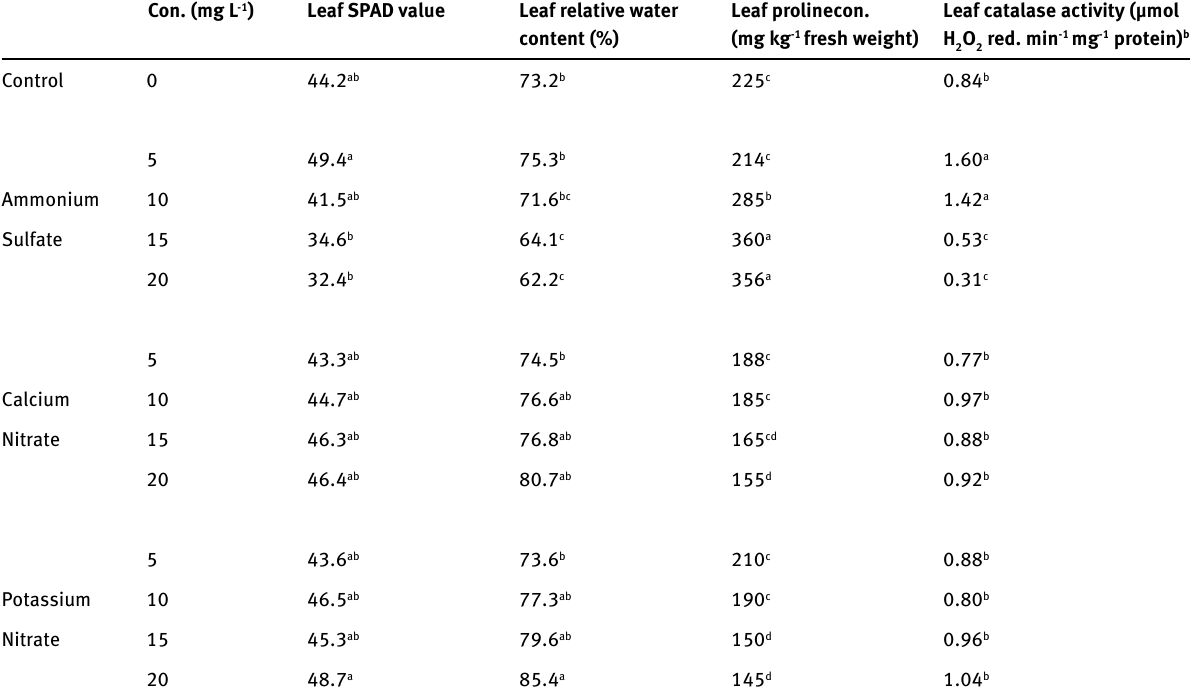
Table 1: Changes in some physiological characteristics of leaves of cut rose flowers affected by different concentrations of ammonium and nitrate forms in holding solution. In each column comparison of means was done at 5% Duncan test a Con. (mg L -1